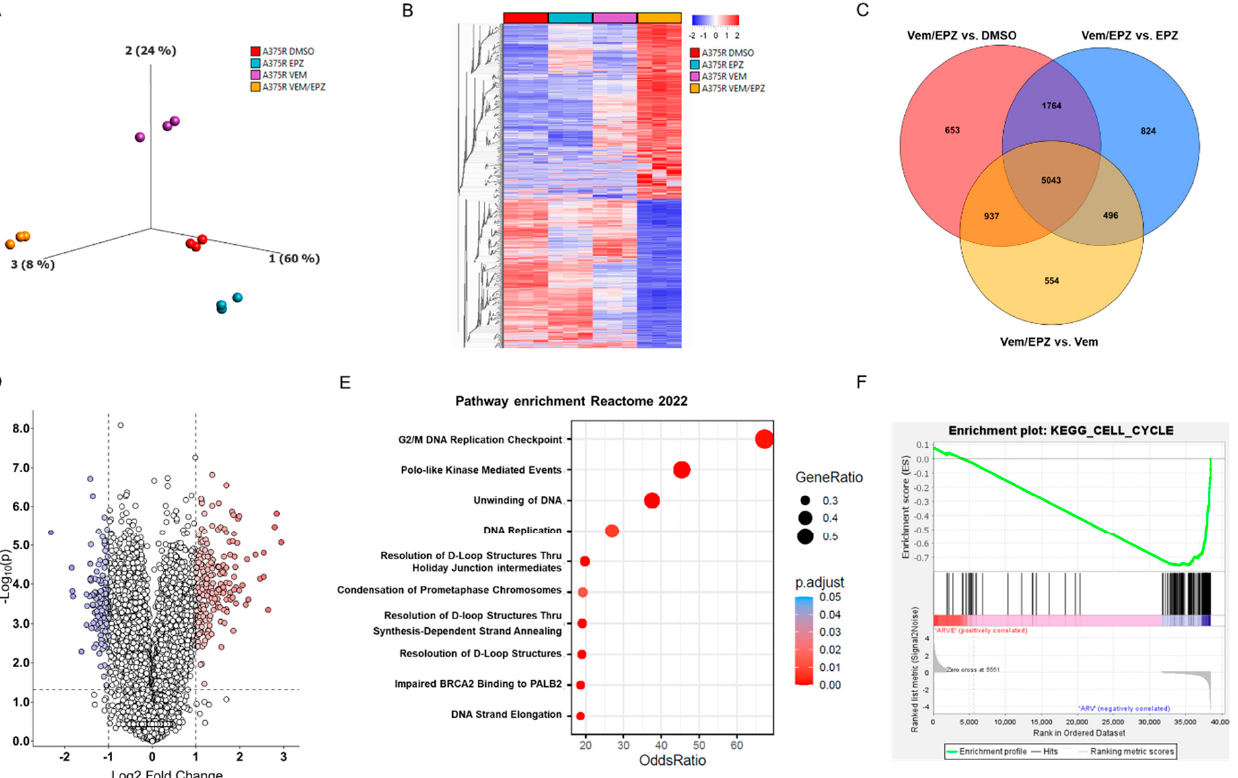
Figure 4. The combined treatment of A375R cells with vemurafenib and EPZ results in a significant change in the expression of cell-cycle-associated genes. ( A ) Principal component analysis (PCA) of the gene profiles of A375R cells treated with DMSO (control), EPZ (5 µ M), vemurafenib (Vem) (10 µ M) or vemurafenib and EPZ. ( B ) Heatmap represents significantly differentially expressed genes of A375R cells treated as described above. ( C ) Venn diagram of downregulated genes in A375R cells treated with vemurafenib and EPZ compared to all other conditions. ( D ) Volcano plot of differentially expressed genes in A375R cells treated with vemurafenib and EPZ compared to vemurafenib treatment alone. ( E ) Reactome pathway analysis for genes downregulated by vemurafenib and EPZ in A375R cells. ( F ) KEGG gene-enrichment analysis for genes downregulated by vemurafenib and EPZ in A375R cells.